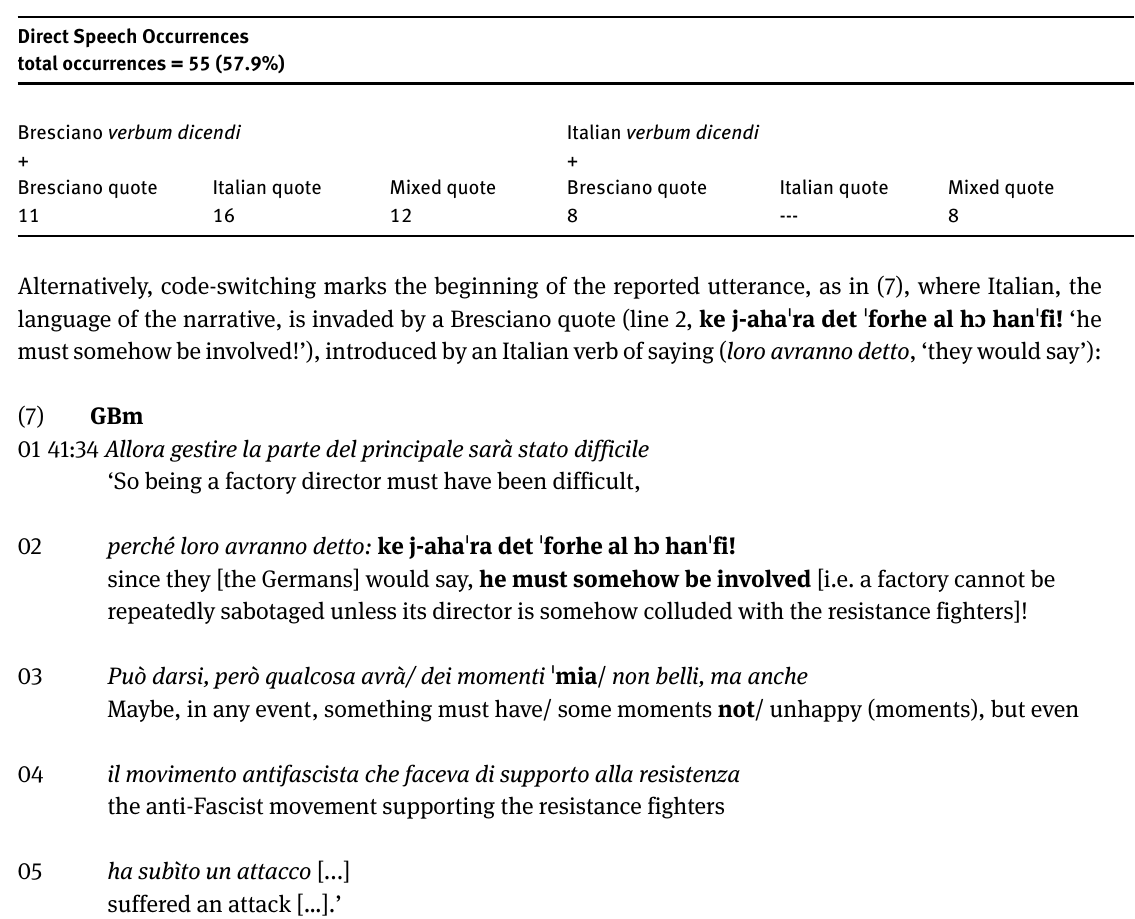
Table 2: Breakdown of DS occurrences